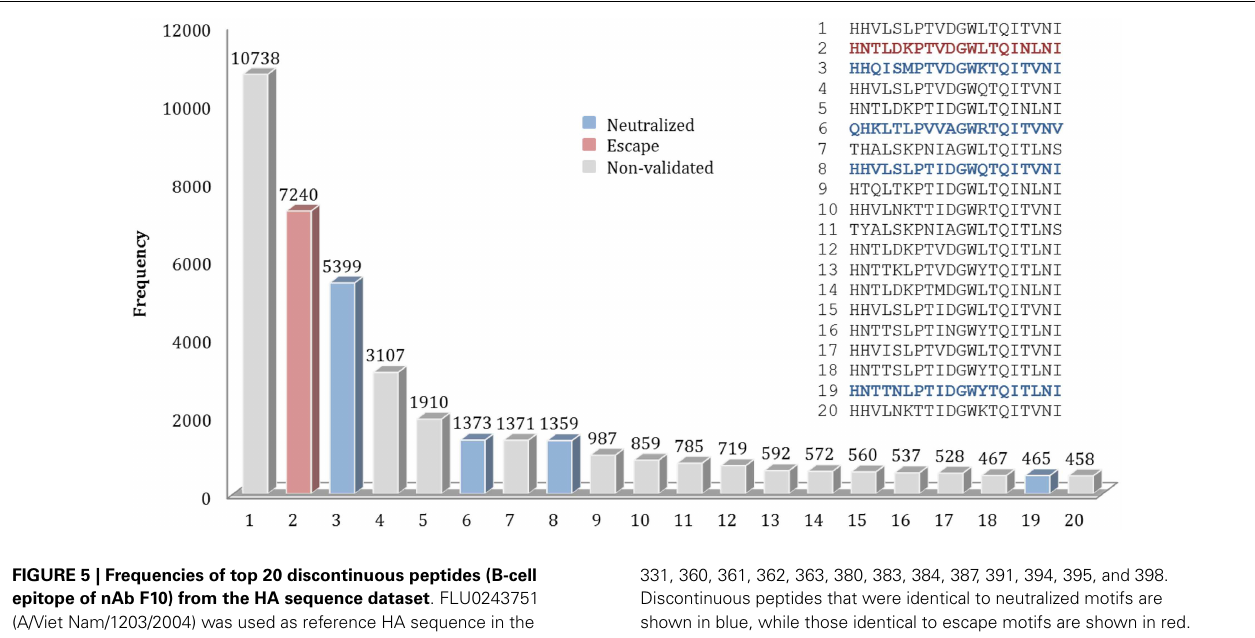
FIGURE 5 | Frequencies of top 20 discontinuous peptides (B-cell epitope of nAb F10) from the HA sequence dataset . FLU0243751 (A/Viet Nam/1203/2004) was used as reference HA sequence in the analysis of F10 B-cell epitopes.The corresponding positions of discontinuous peptides on FLU0243751 are: 24, 44, 46, 48, 304, 305, 306,